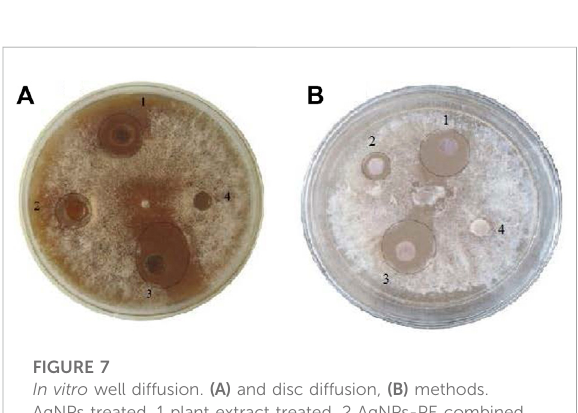
FIGURE 7 In vitro well diffusion. (A) and disc diffusion, (B) methods. AgNPs treated, 1 plant extract treated, 2 AgNPs-PE combined treated, 3 and water as control